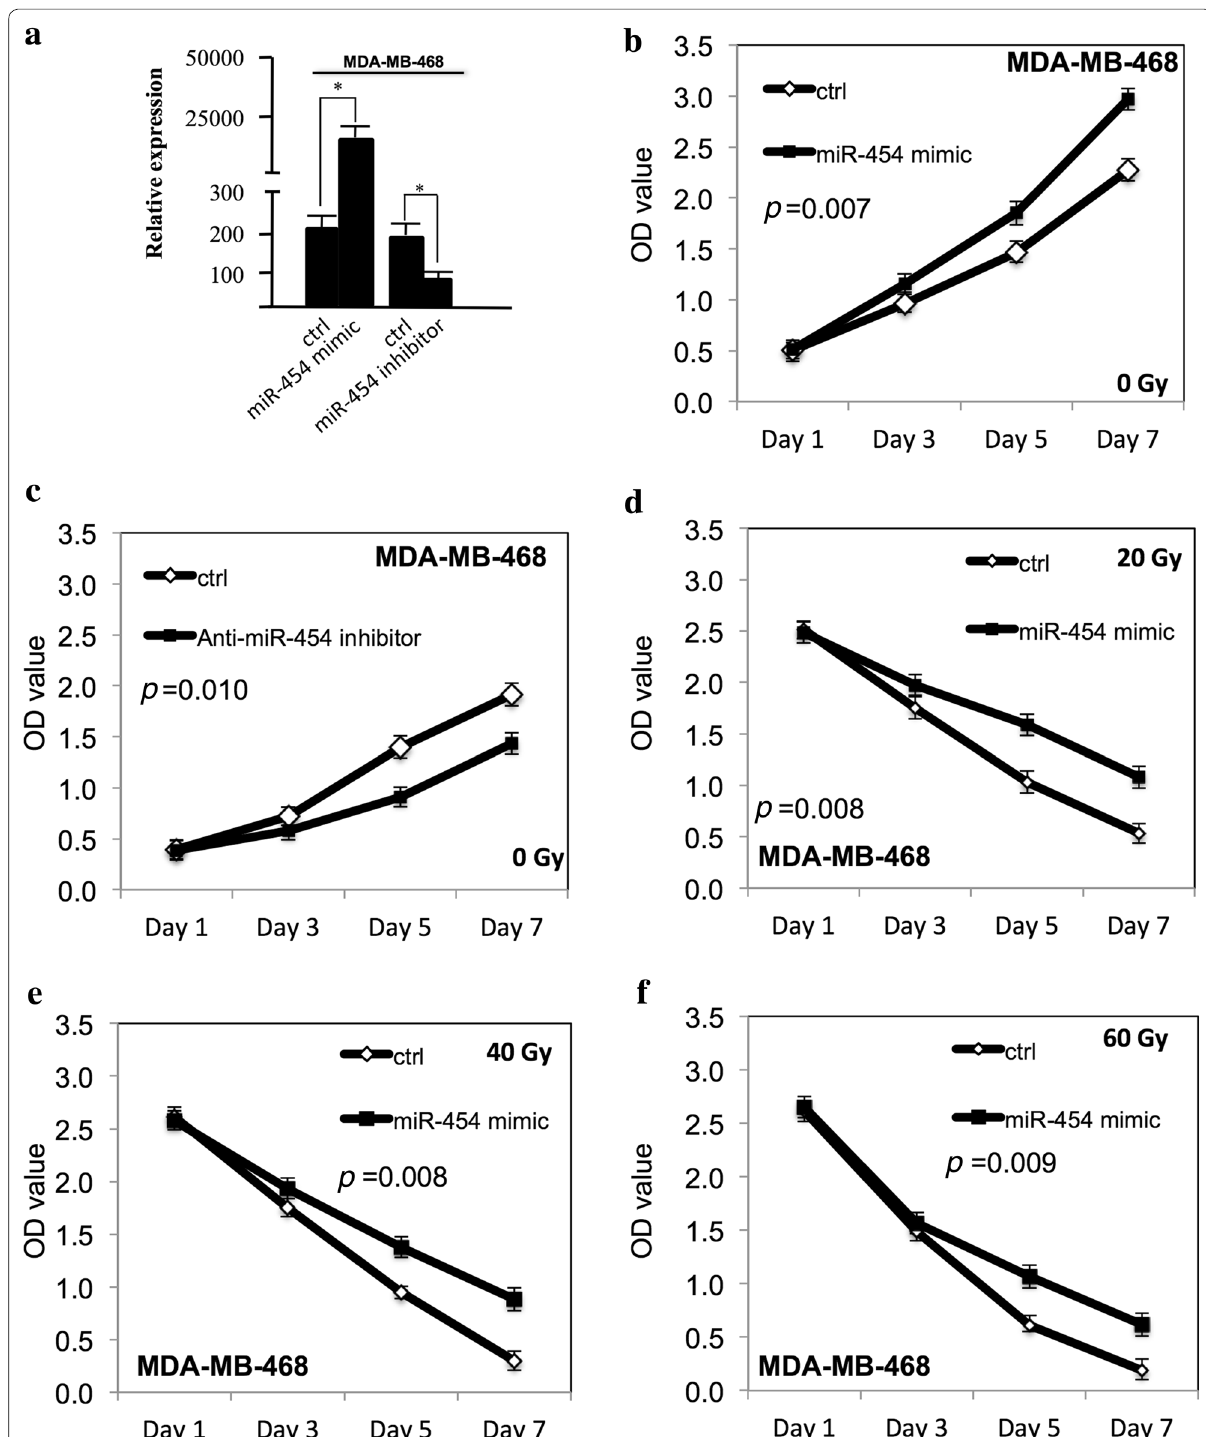
Fig. 2 miR-454 increased the proliferation of MDA-MB-468 cells and improved the survival at ionizing radiation. a The miR-454 expression level was determined by qRT-PCR in MDA-MB-468 cells transfected with either miR-454 mimic or anti-miR-454 inhibitor. b The proliferation of MDA-MB-468 cells after transfection of miR-454 mimic. c The proliferation of MDA-MB-468 cells after transfection with anti-miR-454 inhibitor. d The proliferation of MDA-MB-468 cells after miR-454 overexpression at 20 Gy. e The proliferation of MDA-MB-468 cells after miR-454 overexpression at 40 Gy. f The proliferation of MDA-MB-468 cells after miR-454 overexpression at 60 Gy. All experiments were performed in